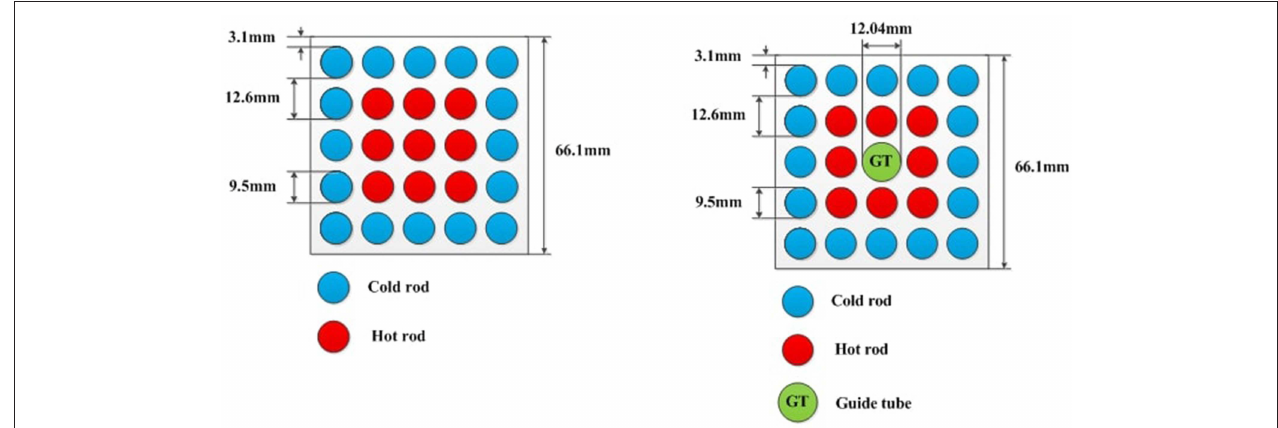
FIGURE 5 | Test bundle setup in the NPIC 5